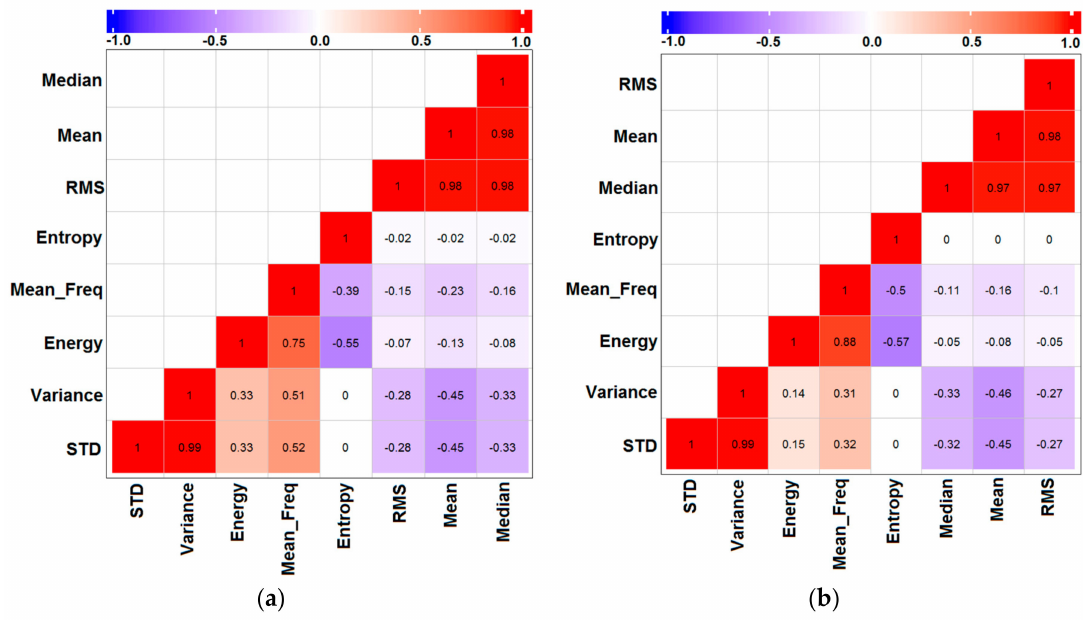
Figure 5. Correlation matrix that depicts the relationship between features for the ( a ) Phone and ( b ) Watch